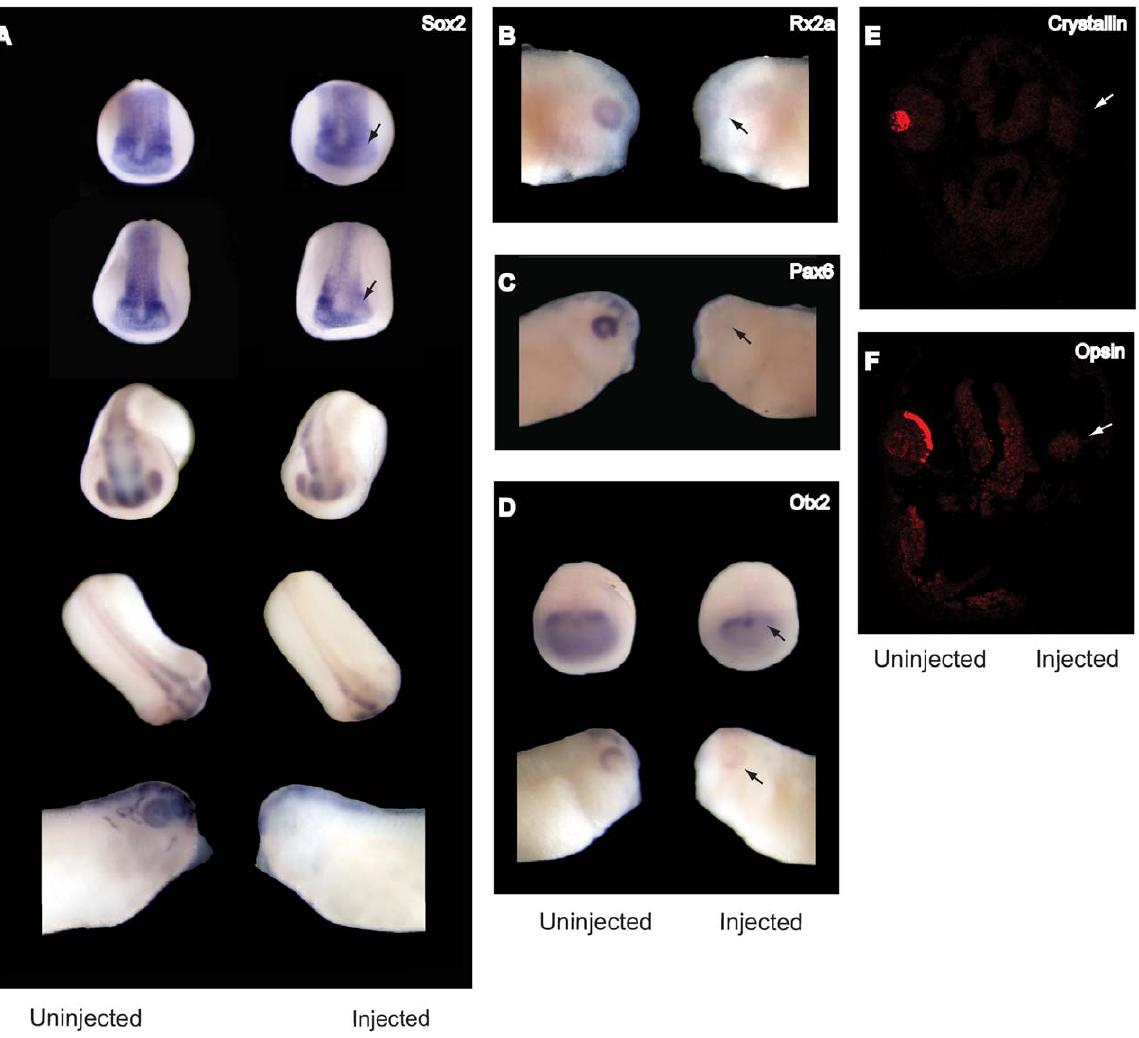
Figure 6. Loss of function of SPC7 diminishes expression of neural and eye markers . (A-D) Whole mount hybridization in situ of embryos injected unilaterally with 90 ng SPC7 morpholino. Injected sides are shown to the right. (A) Frontal, dorsal, and lateral views showing Sox2 expression in control (left) and SPC7-MO unilaterally injected (right) embryos. Early- (top row) and mid-neurula (second row) embryos showing diminished Sox2 staining on the SPC7 morpholino injected side, most obviously in the eye anlage but apparent throughout the head folds (arrows). The loss of expression became more obvious at later stages. Row Three: antero-frontal view of stage 22 embryos. Sox2 staining was undetectable in retina, lens, and neural tube, and was reduced in the midbrain on the injected side. Row 4: dorsal view of the same embryos showing that Sox2 staining was absent in the neural tube on the injected side. Bottom row: Stage 35 embryo showed complete loss of Sox2 staining in the eye on the injected side. (B) Lateral views showing Rx2a expression was not detectable on the injected side (arrow). (C) Lateral views showing Pax6 expression pattern in control (left) and injected (right) stage 26–27 embryos. Pax 6 staining was absent in the eye field on the injected side (arrow). (D) Otx2 expression in uninjected control (left) and SPC7-MO unilaterally injected (right) embryos. Top row: antero-dorsal view of stage 14 embryos showing significantly diminished Otx2 expression on the injected side (arrow). Bottom row: Lateral views of control (left) and SPC7 MO-injected (right) sides of the same embryo showing barely detectable Otx2 expression on the injected side (arrow). (E, F) Frontal sections through the head of stage 35 embryos injected unilaterally (injected side to the right) with 30 ng SPC7-MO showing expression of b -Crystallin (E) and Opsin (F) expression on the non-injected side